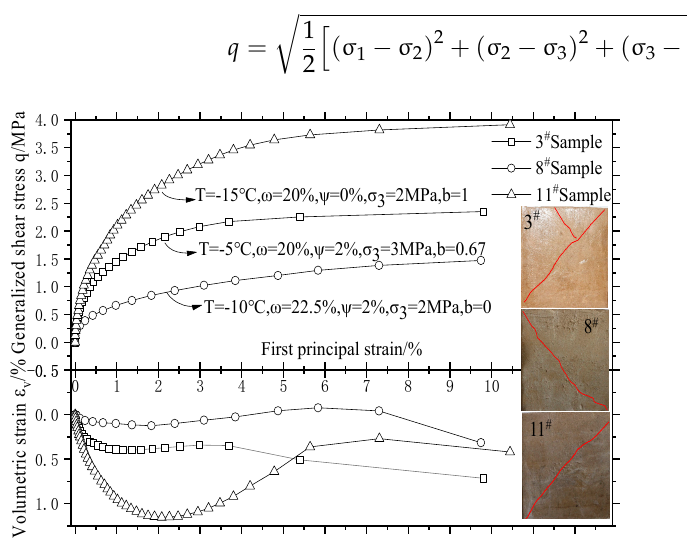
Figure 4. True triaxial stress–strain and volume deformation curves of frozen calcareous clay.